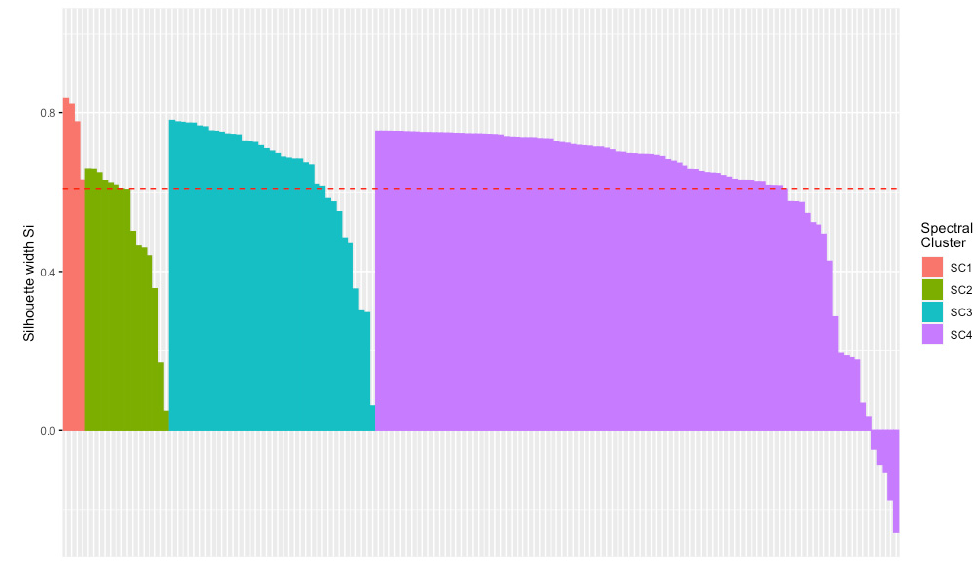
Figure 7. Natural clusters from bisections of the Fiedler vector.